Question: Does the plotted quantity increase or decrease?
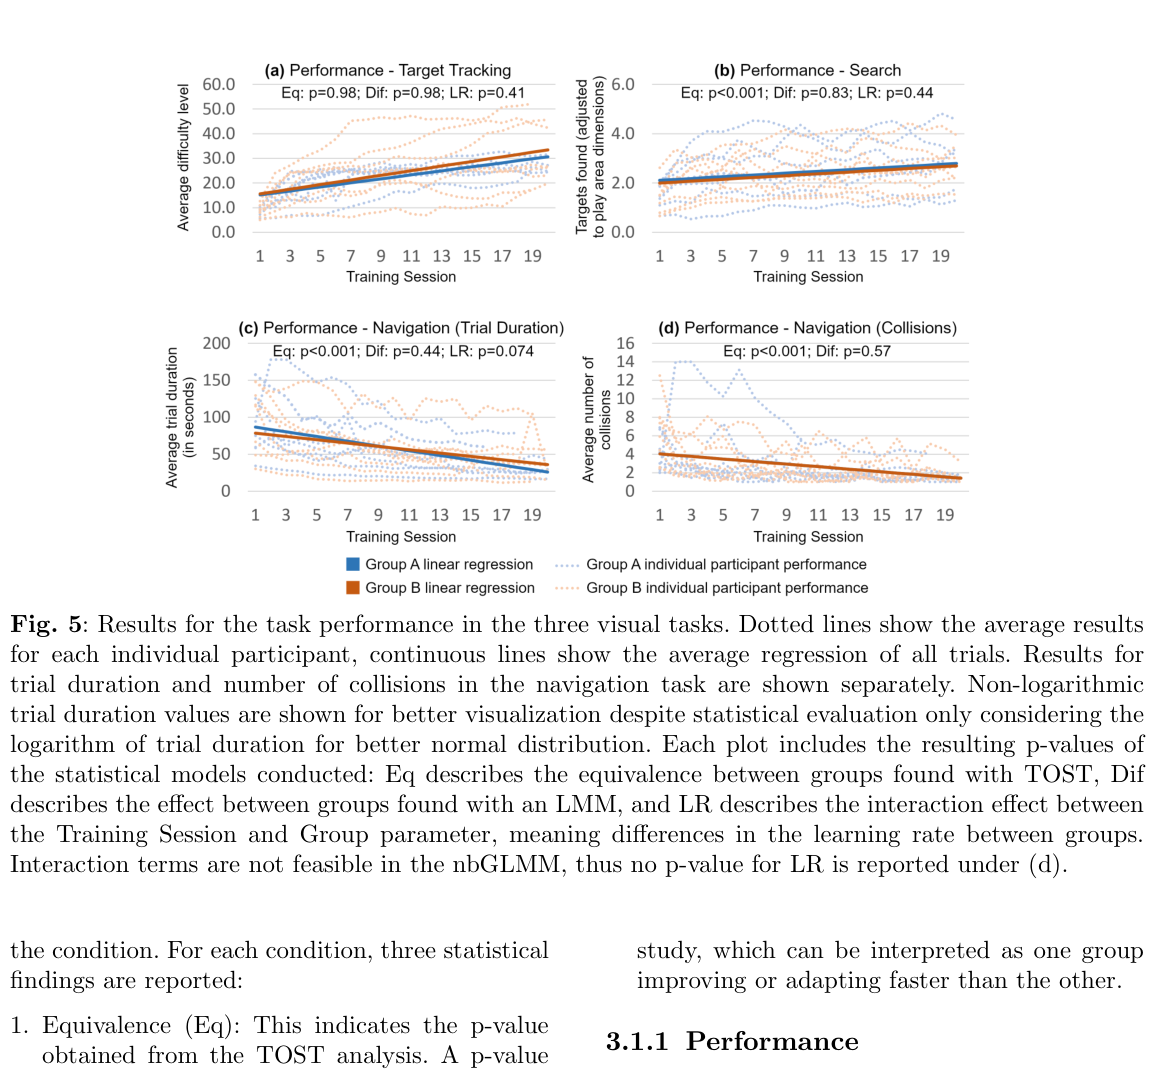
Answer: increasing